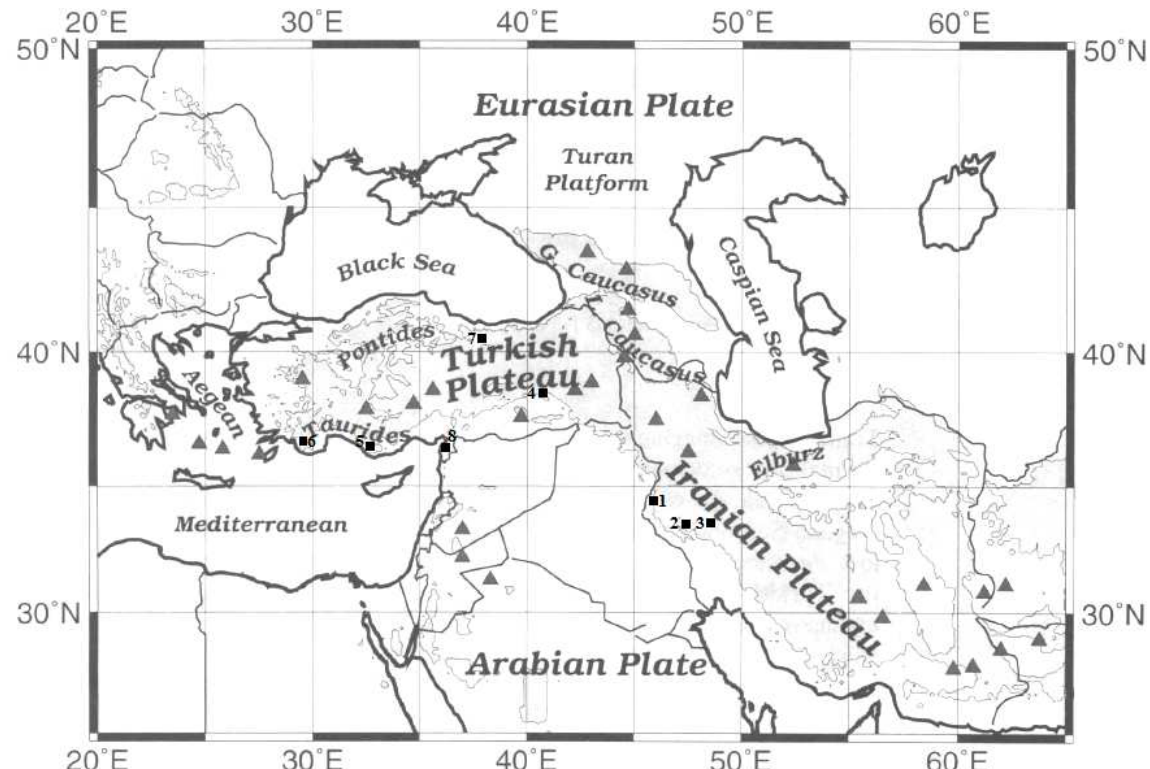
F IGURE . 1. Map of sampling localities from the Turkish-Iranian Plateau for specimens used in this research. (1) Sarpol-e zahab, (2) Darreh shahr, (3) Poldokhtar, (4) Diyarbakir, (5) Mersin, (6) Antalya, (7) Tokat, (8)